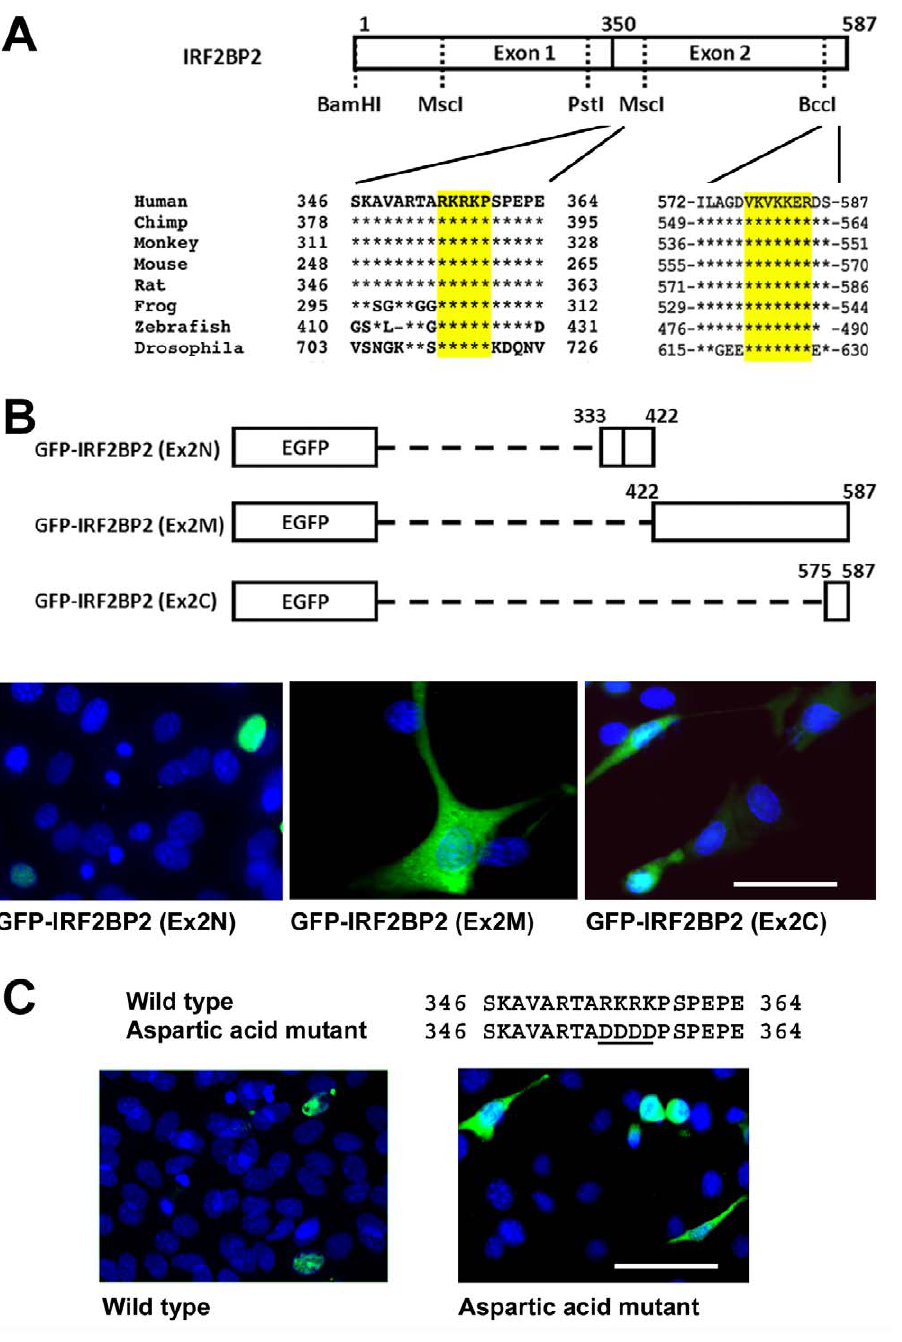
Figure 3. Identification of the NLS within the C-terminal half of IRF2BP2. A. Two putative NLS sequences were identified in conserved regions of IRF2BP2. Core arginine (R) and lysine (K) sequences are highlighted in yellow. B. GFP fusion constructs with the amino acid positions indicated were tested in C 2 C 12 myoblasts to reveal that the sequence between amino acid 333 and 422 contains the functional NLS of IRF2BP2. C. Site-directed mutagenesis converting the R and K to aspartic acid (D) residues prevented nuclear localization. Scale bar, 50 m m.